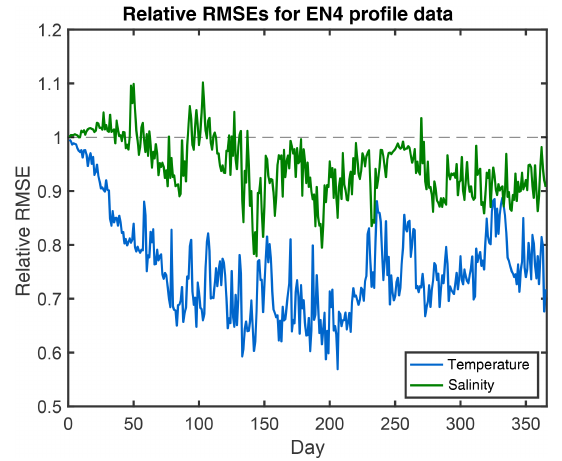
Figure 8. Root mean square errors (RMSEs) of the assimilation ex- periment relative to the free run computed with regard to the in situ EN4 profile observations. Shown are the relative RMSEs for tem- perature (blue) and salinity (green). Temperature is more strongly improved than